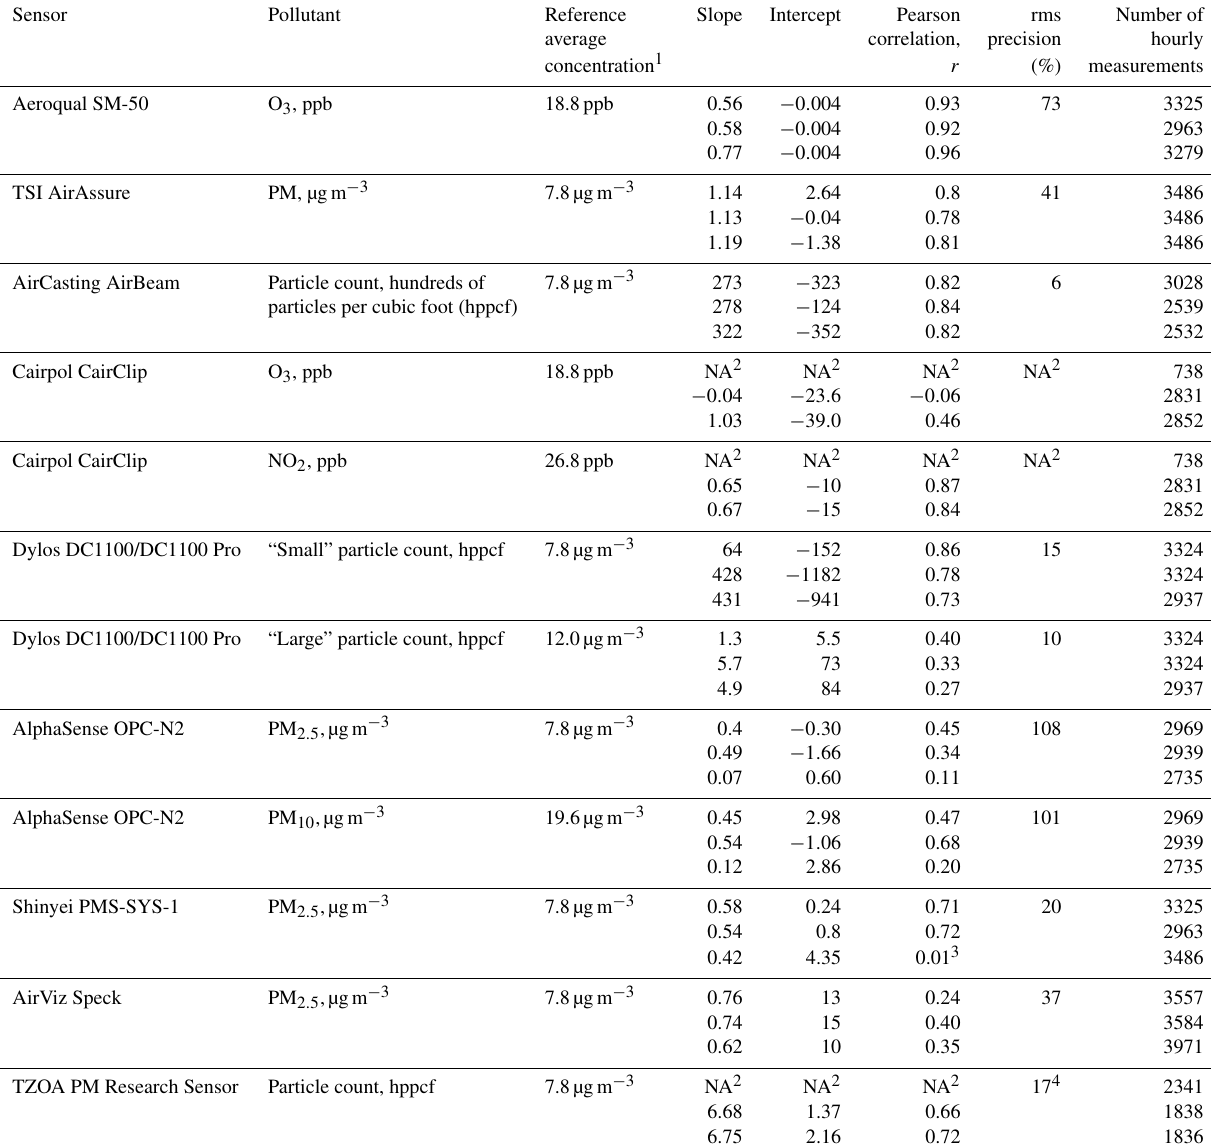
Table 3. Regression and precision results for CAIRSENSE sensors (1h time averaged).